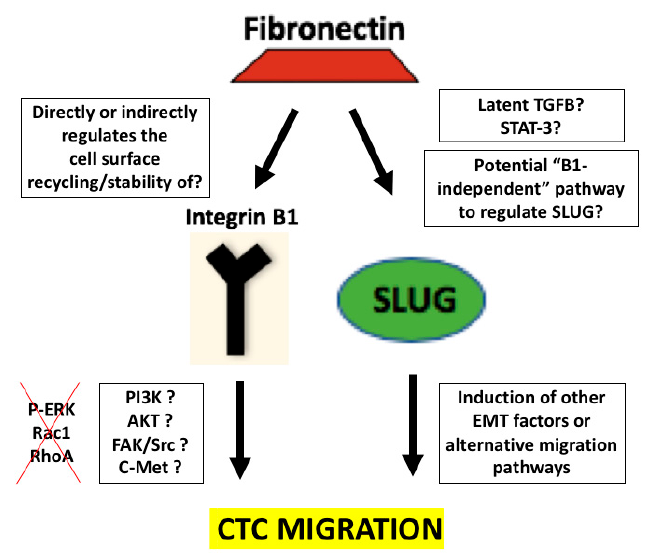
Figure 6. Proposed model of how FN1 overexpression in CTCs contributes to their enhanced migration capability. It has previously been observed that greater levels of FN1 expression in tumors has been correlated with poorer patient survival. Interestingly, our established CTC lines demonstrated a pronounced increase in FN1 as compared to our primary tumor cell lines. We have also previously reported that FN1 regulates both ITGB1 and SLUG. In this paper, we now show that FN1 regulates ITGB1 and SLUG via two separate and independent pathways. Furthermore, both ITGB1 and SLUG are necessary for FN1-mediated migration. This figure contains both confirmed data, as well as areas still in need of research.